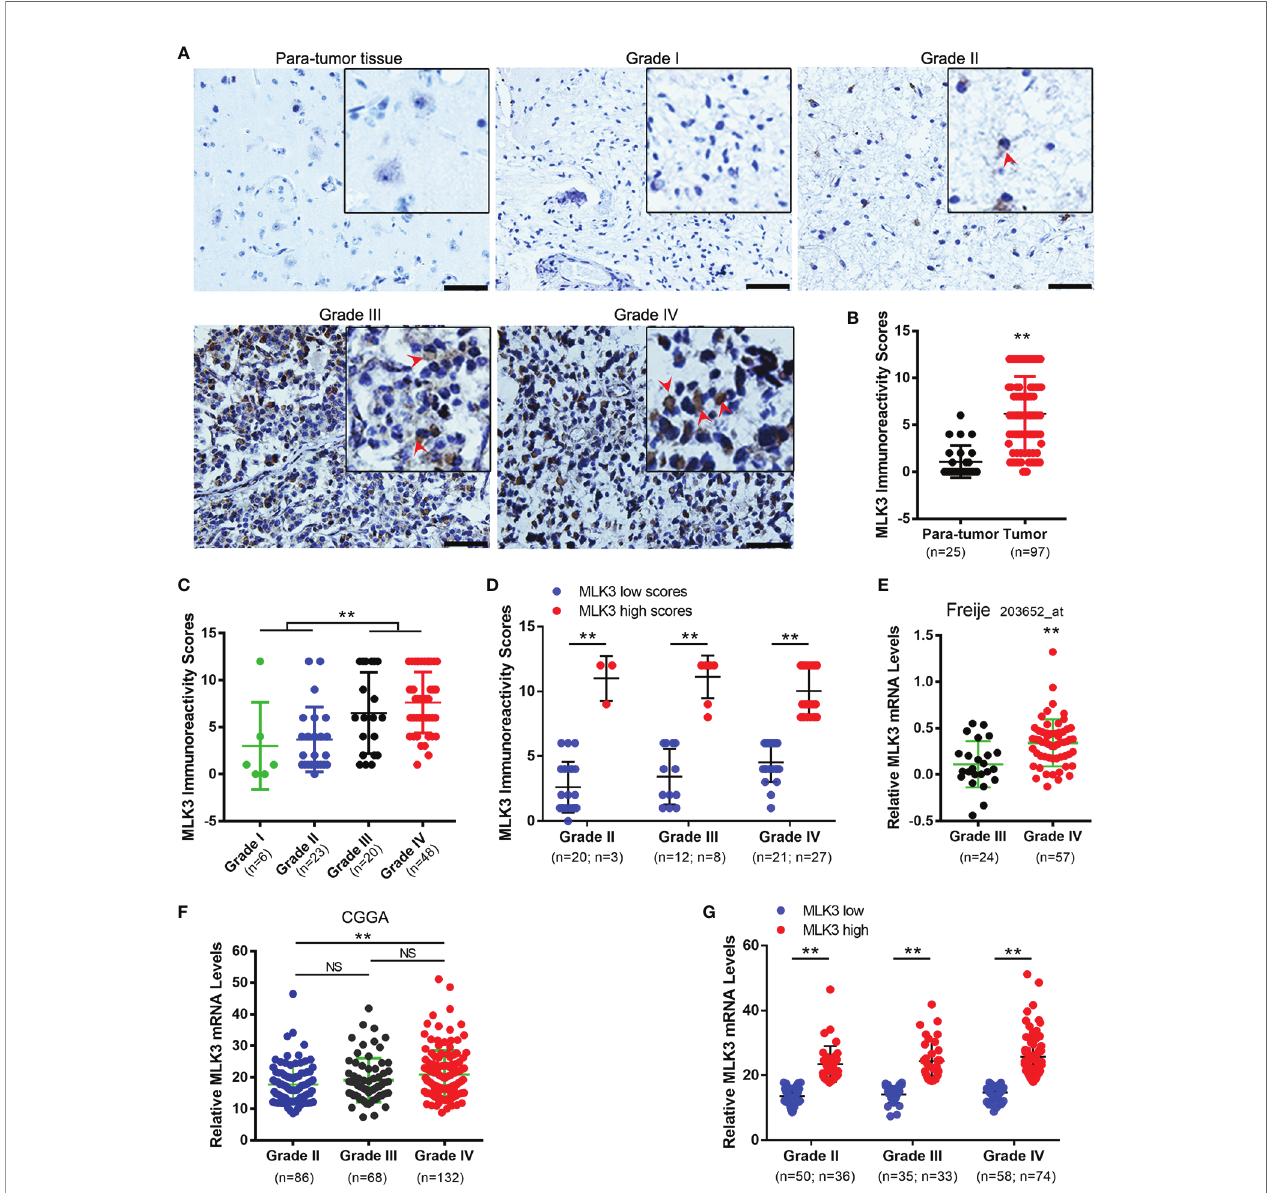
FIGURE 1 | MLK3 is highly expressed in high-grade human glioma specimens. (A – C) MLK3 protein levels are upregulated in high-grade gliomas. (A) Representative immunohistochemistry IHC images of MLK3 in human glioma tissues. Scale bars, 50 m m. (B) MLK3 expression in para-tumor tissues (n = 25) and glioma tissues (n = 97). (C) Comparison of MLK3 expression between low-grade (grade I and II, n = 29) and high-grade (grade III and IV, n = 68) glioma tissues. Mann-Whitney U test. ** P < 0.01. (D) The variation of MLK3 levels in the same grade gliomas. Mann-Whitney U test, ** P < 0.01. (E, F) MLK3 mRNA levels are upregulated in high-grade gliomas. mRNA sequencing-based glioma datasets from Oncomine database (E) and the CGGA database (F) were analyzed by two-tailed Student ’ s t -tests and one-way ANOVA. NS, not signi fi cant. ** P < 0.01. (G) The variation of MLK3 mRNA levels in the same grade gliomas. Two-tailed Student ’ s t -tests, ** P <